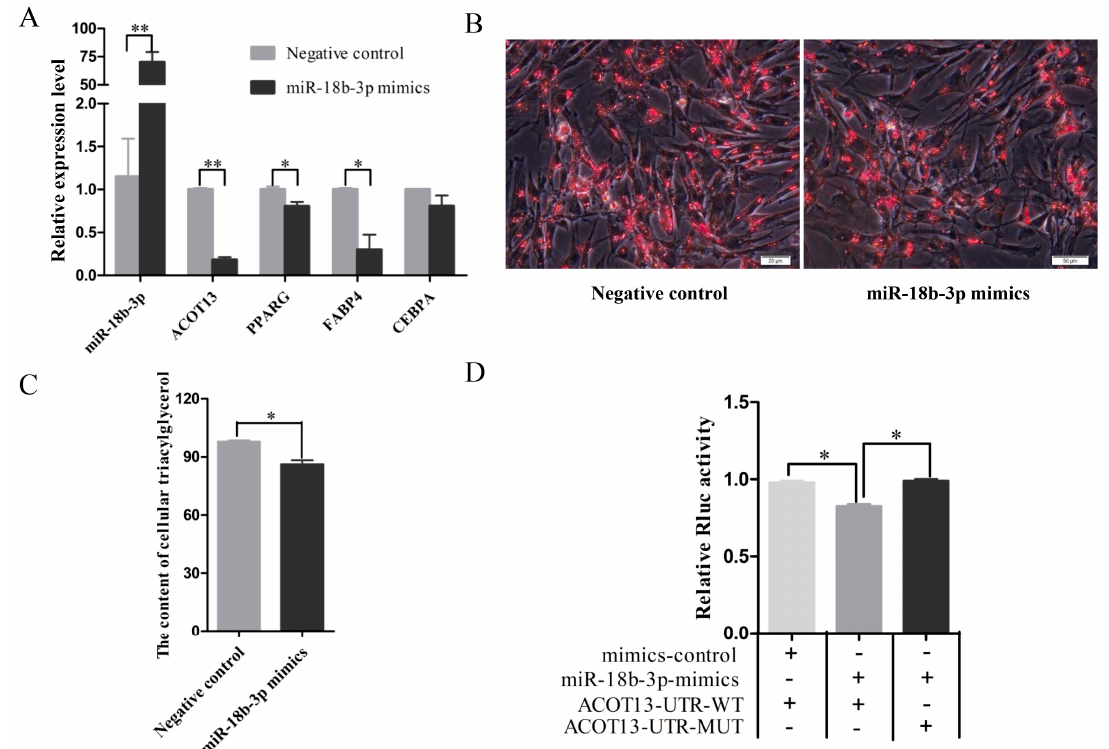
Figure 5. miR-18b-3p inhibited adipocyte di ff erentiation by targeting ACOT13 . ( A ) The expression level of miR-18b-3p and marker genes of adipocyte di ff erentiation after miR-18b-3p overexpression. ( B ) Number of lipid droplets with miR-18b-3p overexpression. ( C ) The concentration of intracellular triglyceride in the miR-18b-3p overexpressing group was significantly lower. ( D ) Verification of miR-18b-3p target gene using luciferase